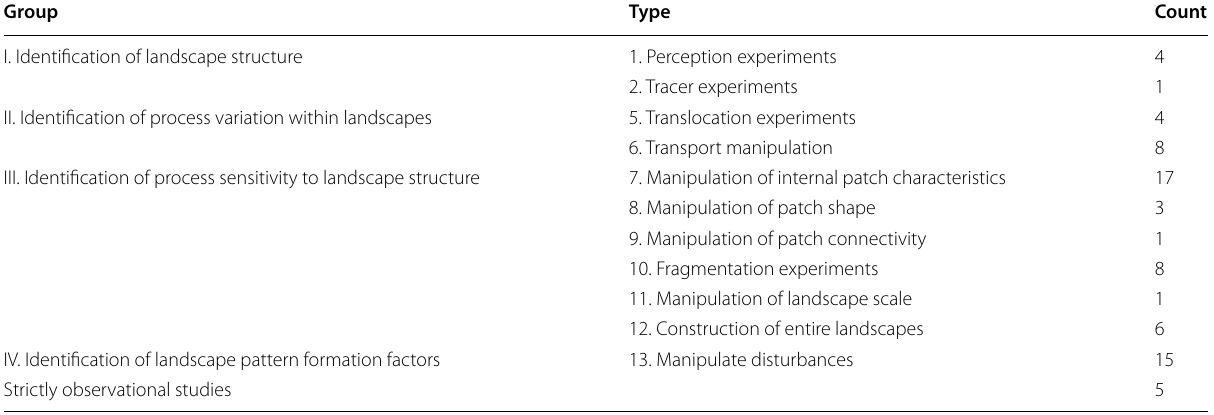
Table 3 Summary of the type of experimental question (sensu Jenerette and Shen 2012) for the 73 non in silico experiments reviewed here Group